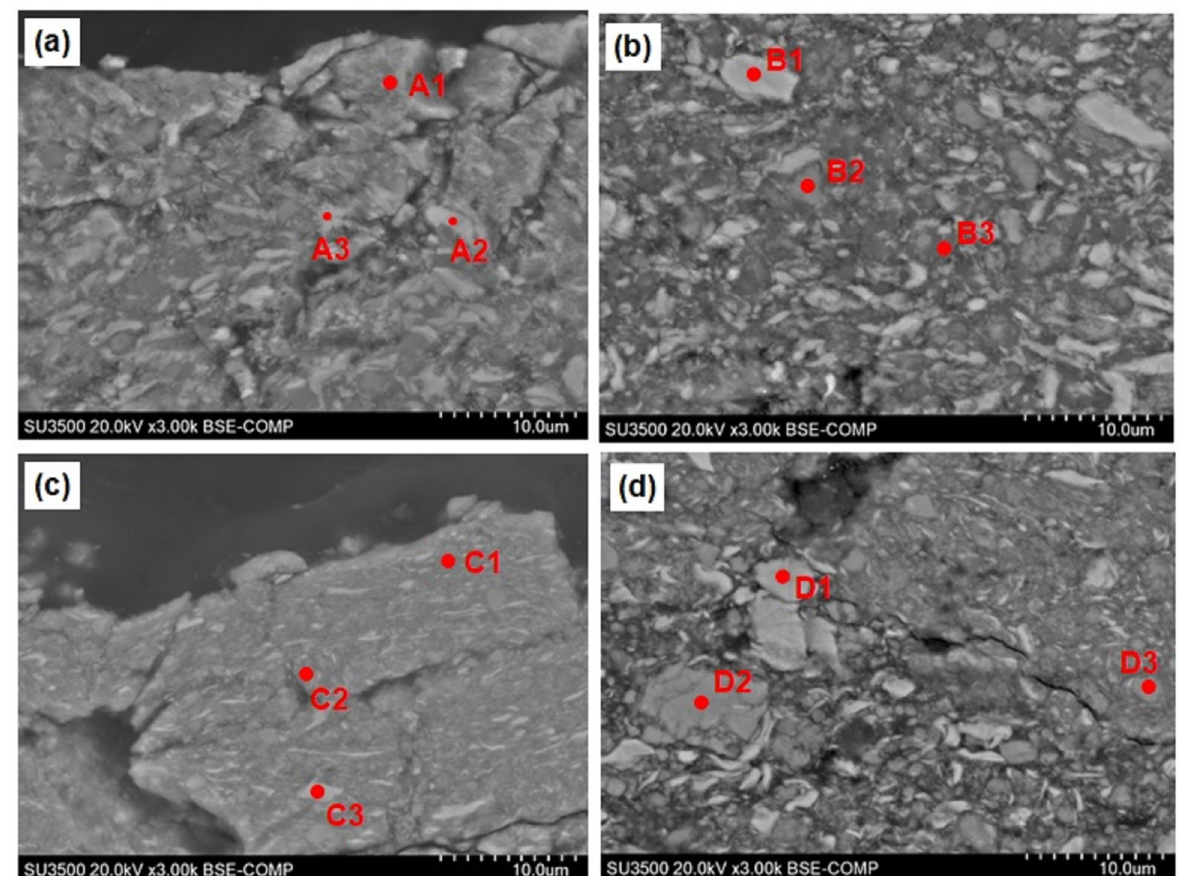
Figure 10. Localized magnification of marked position 1 (a), 2 (b), 3 (c) and 4 (d) in Figure